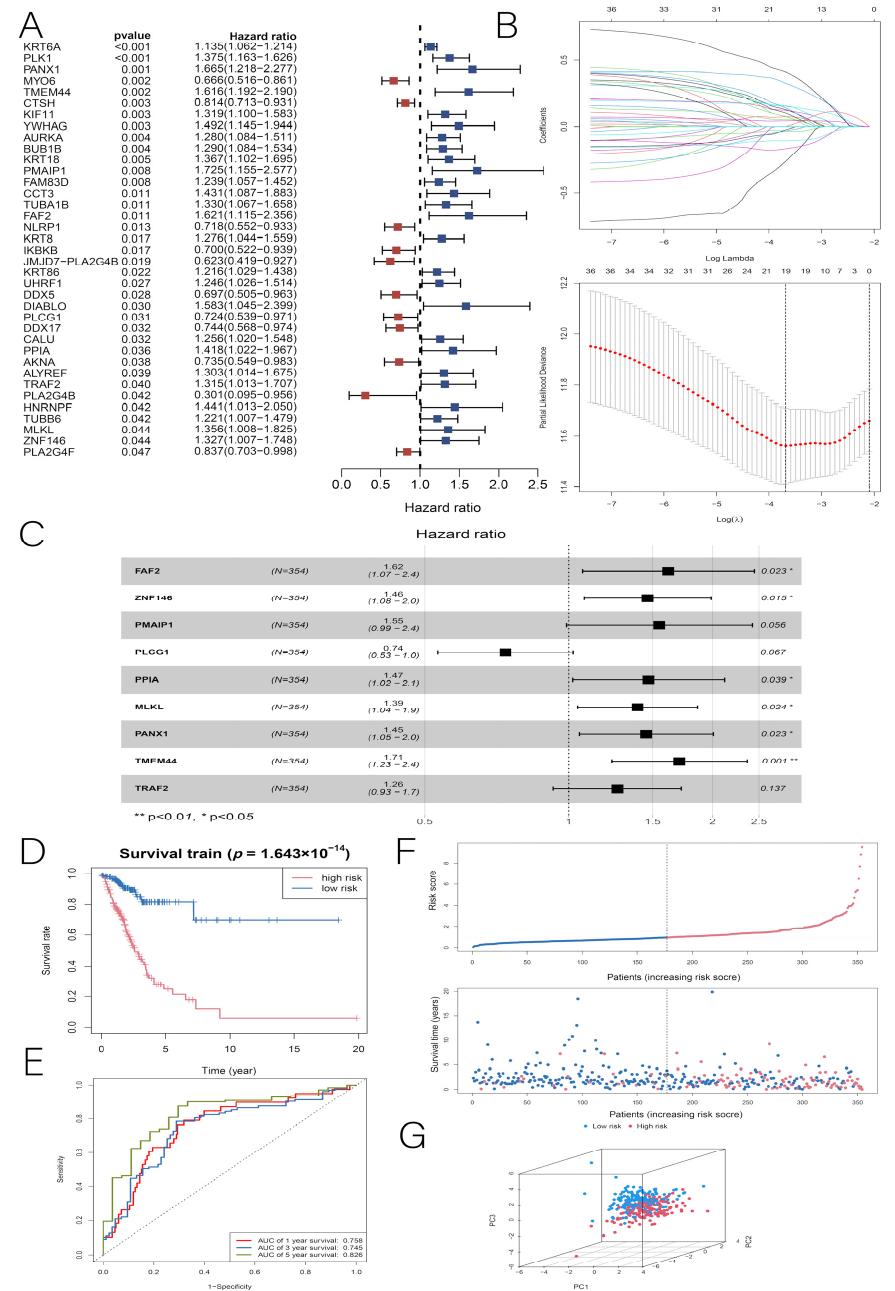
Figure 4. ( A ) Univariate Cox regression forest plot for the training group. ( B ) Inclusion of DENRGs in Lasso regression analysis to screen out prognosis-related DENRGs. ( C ) Multi-factor Cox regression forest plot for the training group. ( D ) K-M plots of OS for patients in the high-risk and low-risk groups in the training group. ( E ) ROC curves for the training group with 1-year, 3-year, and 5-year OS. ( F ) Risk survival status plots for the training group. ( G ) PCA distribution plot for the training group. * p < 0.05, ** p <